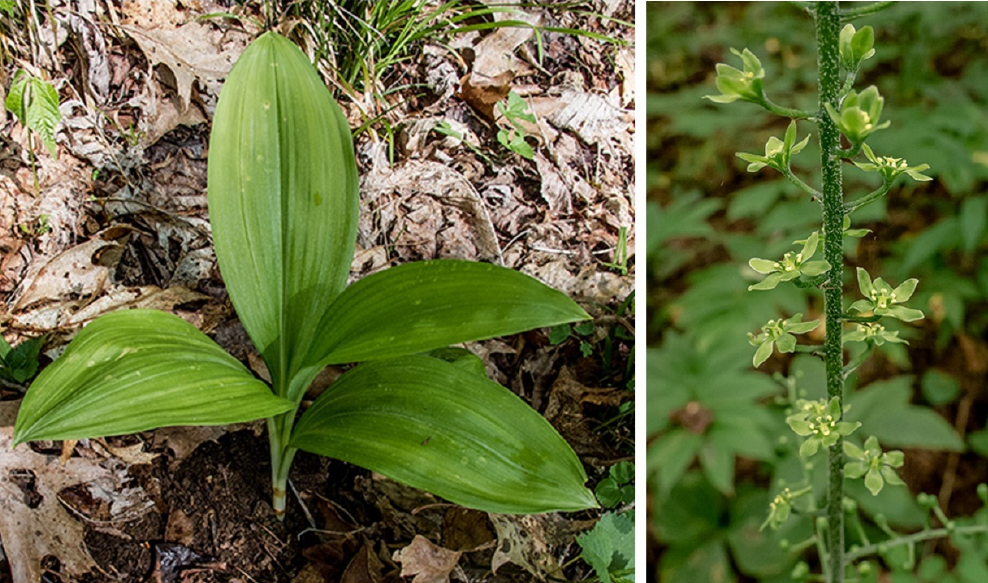
Figure 2. V. parviflorum in situ before blooming ( left ). In the later stages of growth, a stem protrudes from the base of the plant and blooms with pale green flowers ( right ) [19].